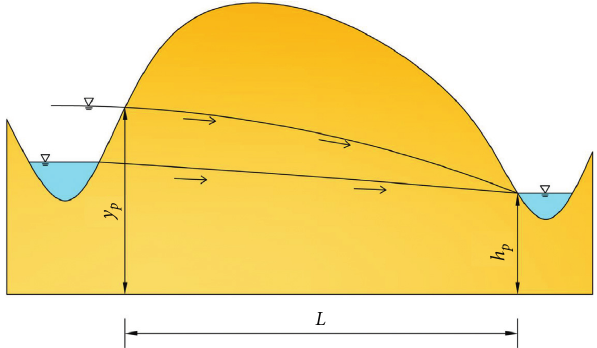
Figure 3: Reservoir model.